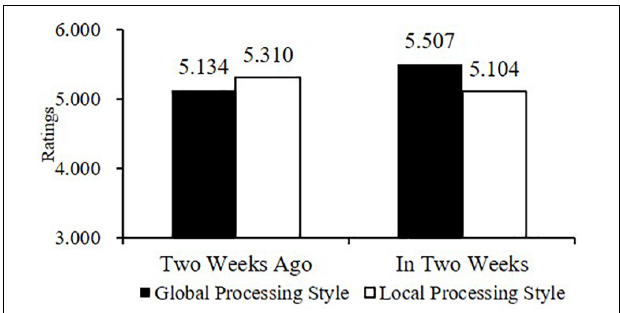
FIGURE 4 | Results of the Two-Way ANOVA in Study